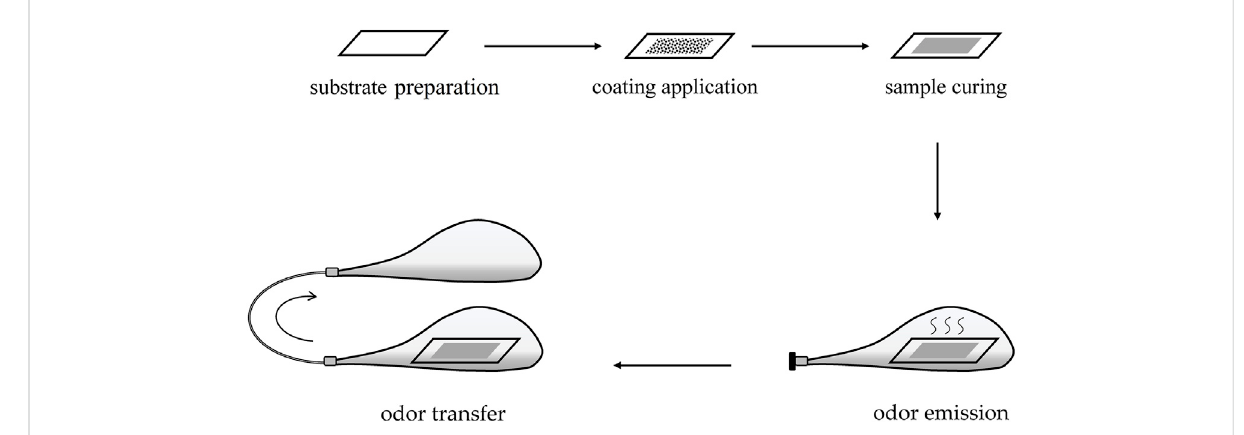
FIGURE 1 Gas preparation process for odor evaluation.